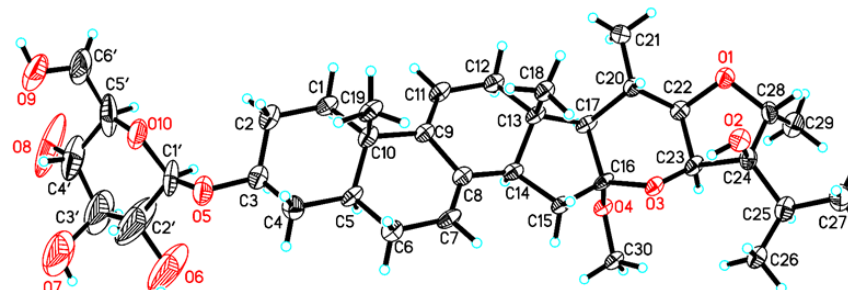
Figure 4. X-ray ORTEP drawing of 1 .